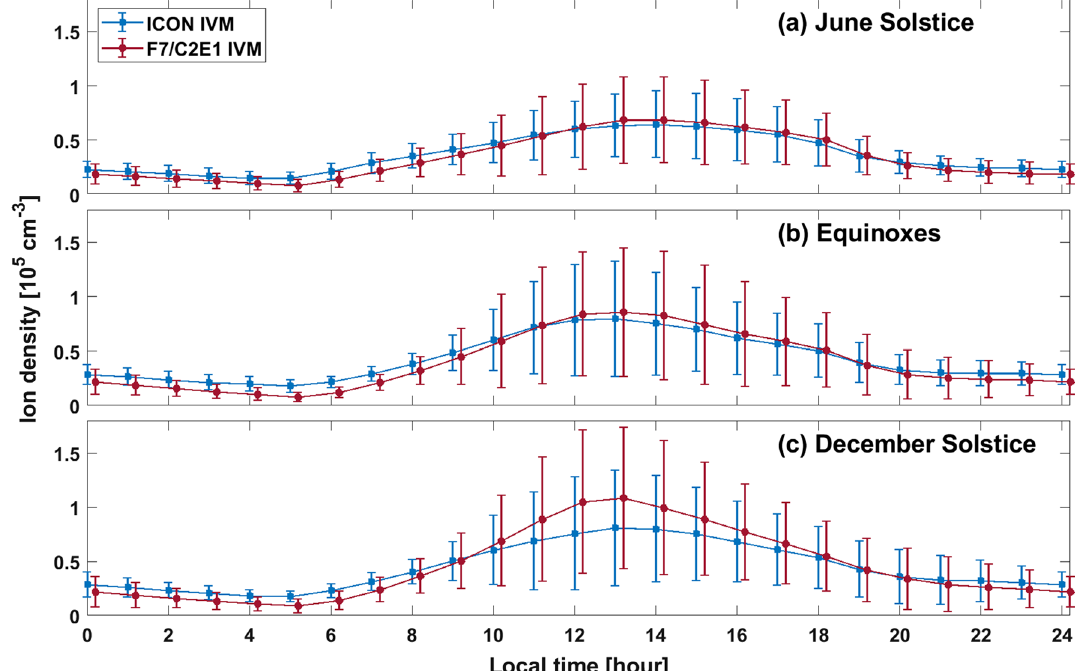
Fig. 3 Diurnal variations of the ion density observed by F7/C2E1 and ICON satellite during the solar minimum period (December 2019 to November 2020) for three seasons. The error bars indicate the median absolute